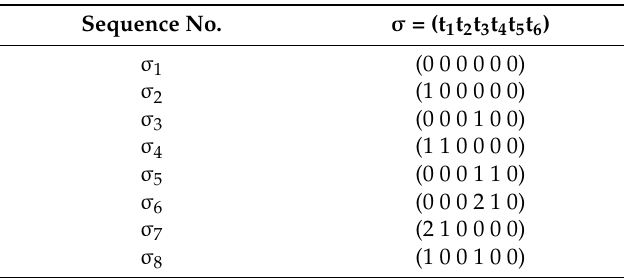
Table 1. Usable sequences of Example 1.